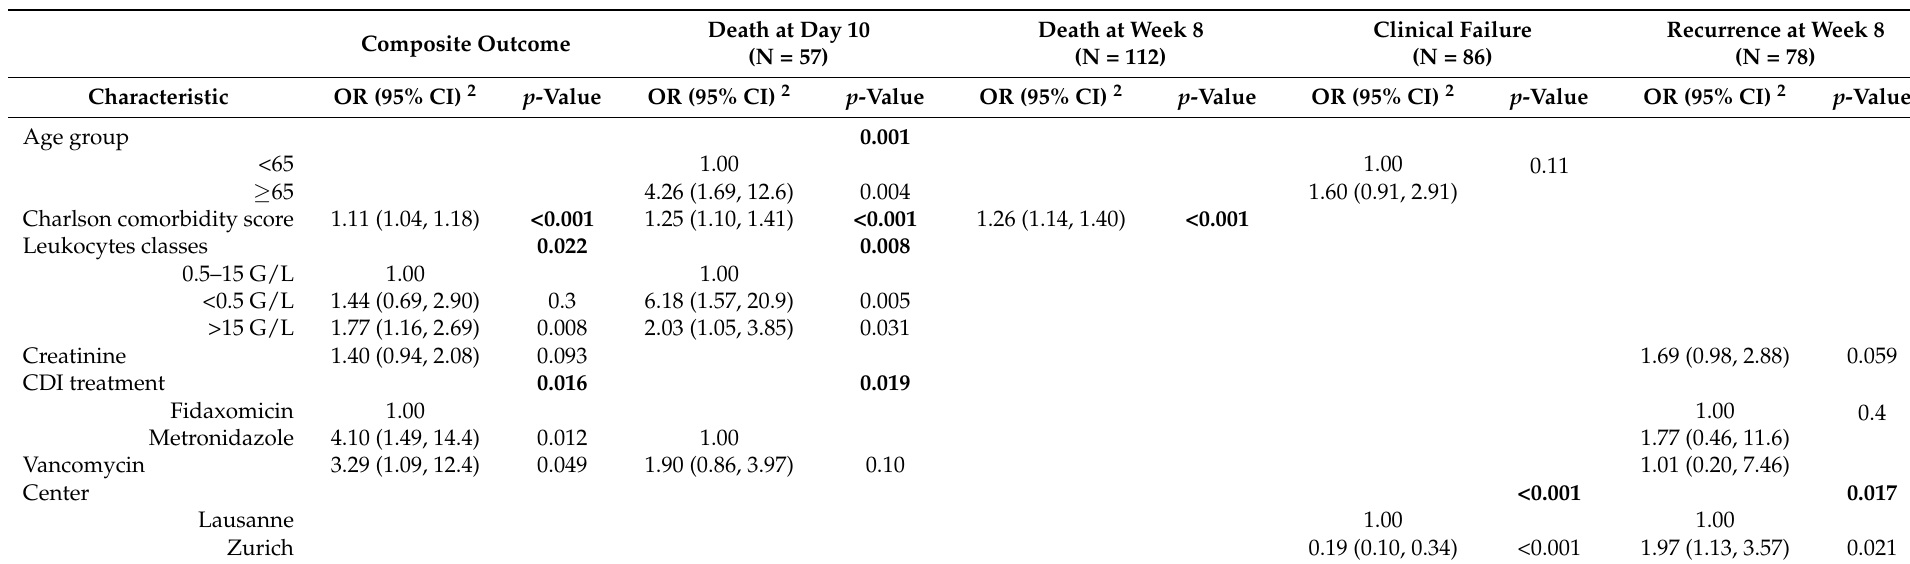
Table 3. Multivariate analyses for the composite outcome 1 , death at day 10, death at week 8, clinical failure and recurrence at week 8. Composite Outcome